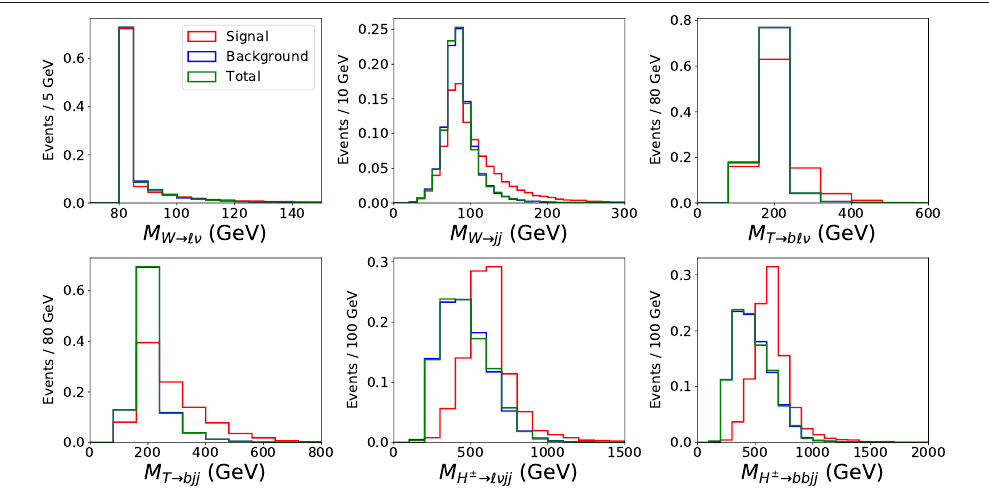
Figure 3. Invariant mass distributions for reconstructed particles in the h MSSM benchmark.